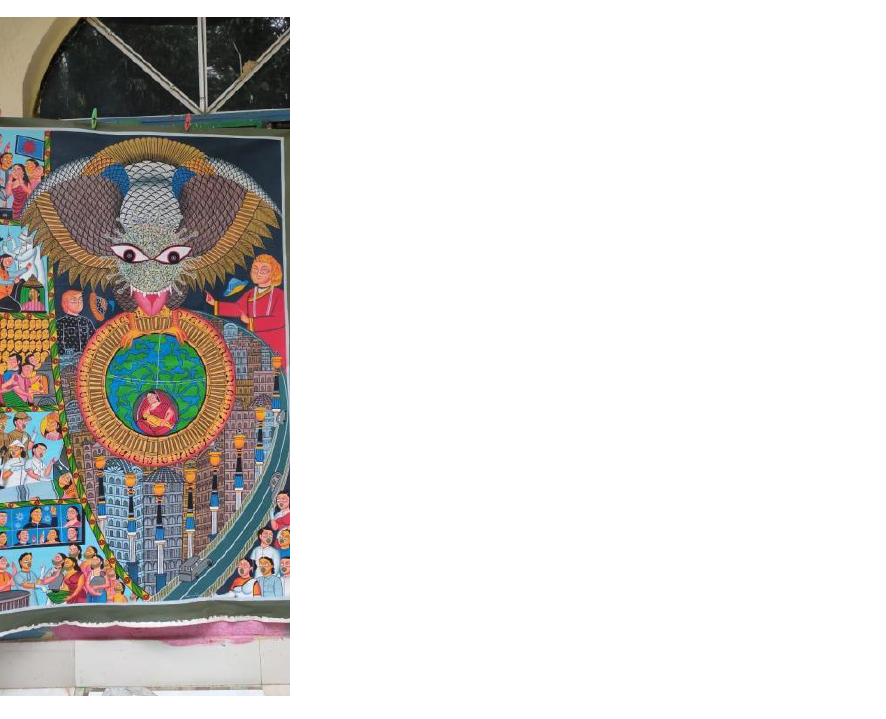
Figure 3. Swarna Chitrakar’s “Pat” Goes Viral. Acknowledgments to Swarna Chitrakar. Anwar Chitrakar’s “pat” (Figure 4) garnered another award for him, namely one by the Indian Council for Cultural Relations.